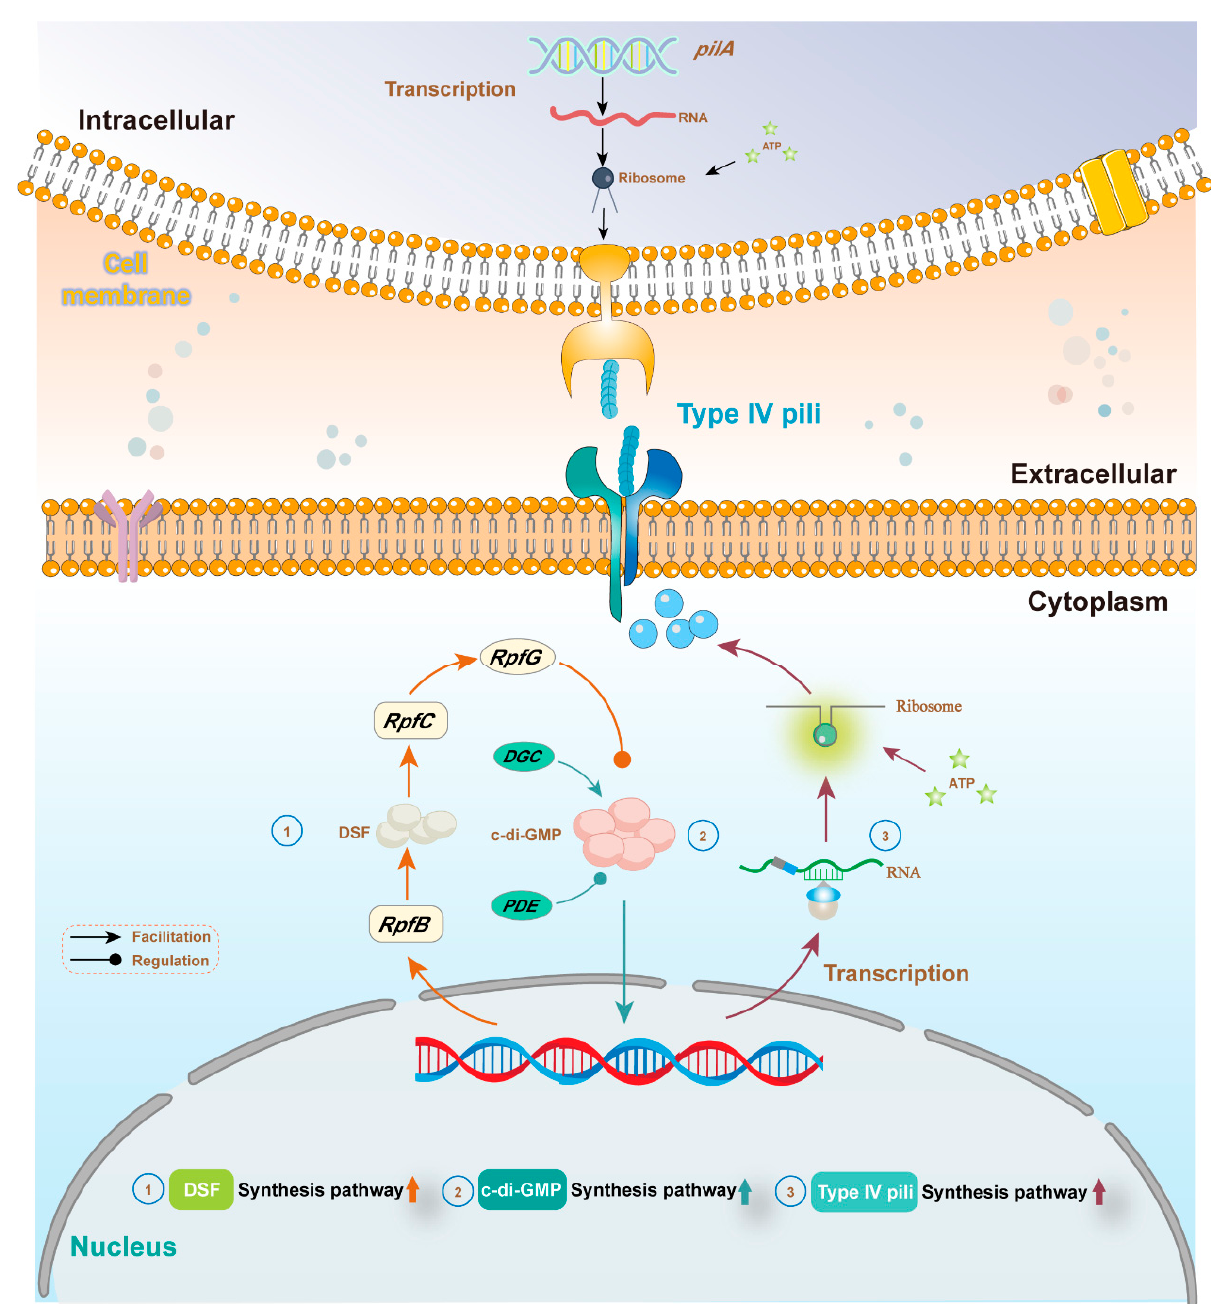
Figure 3. Potential mechanisms of quorum sensing facilitated type IV pili generation, modified from Ref. [41] ; copyright (2020) Elsevier.